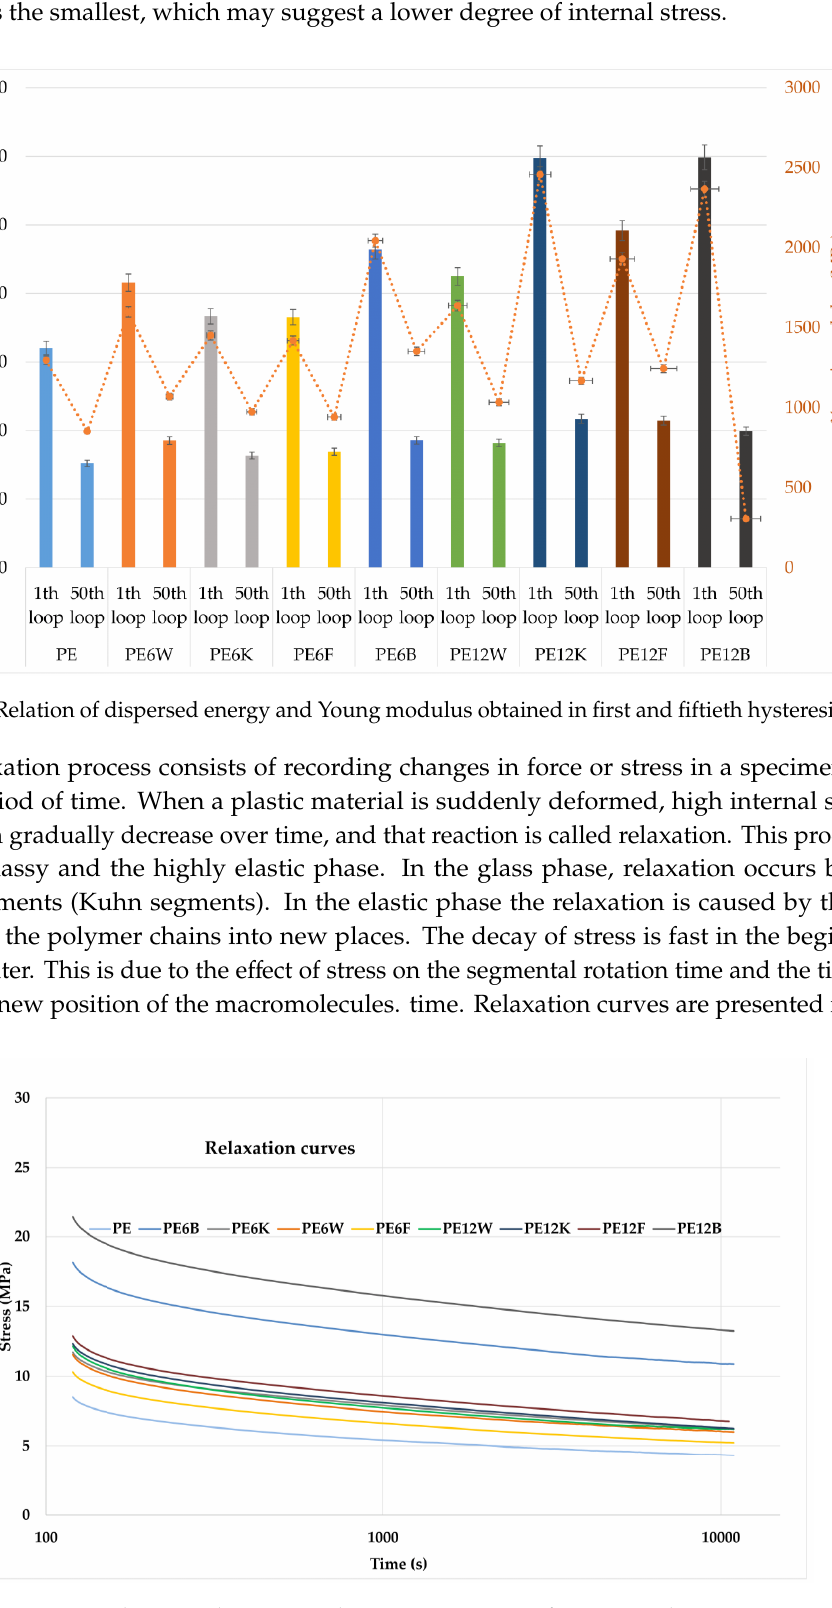
Figure 8. Relaxation short-term relaxation test curves of exanimated composites.